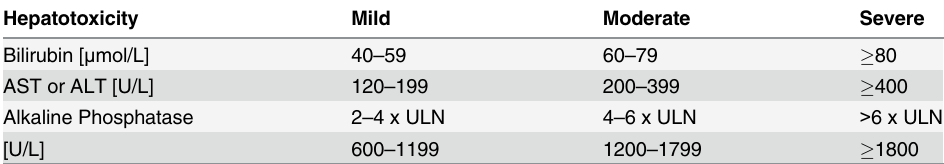
Table 3. Categorisation of abnormal liver biochemistry recorded after index